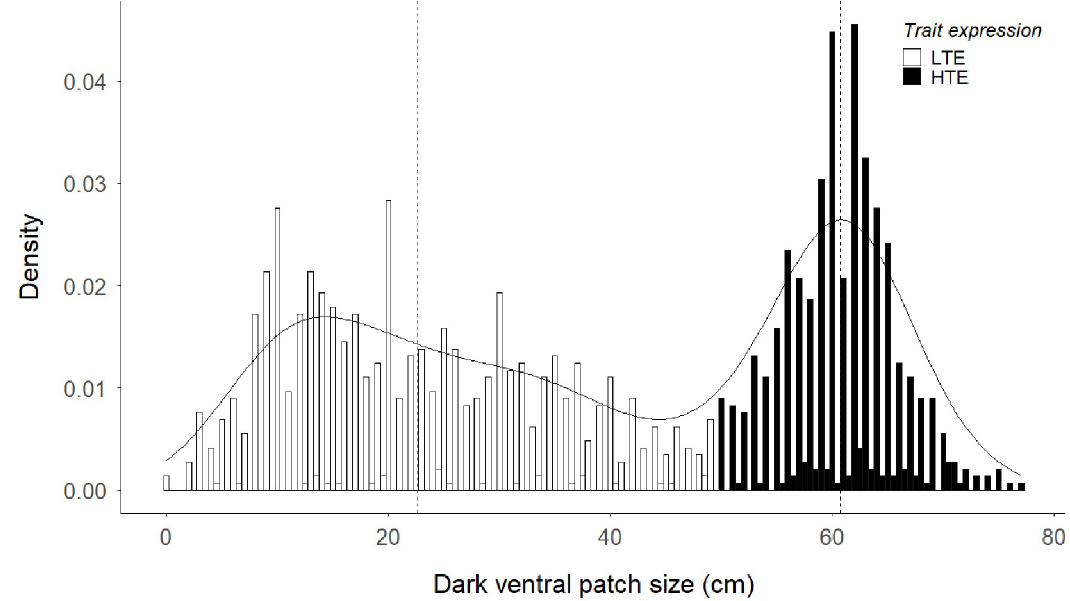
Fig 1. Density plot showing the bimodality distribution of the dark ventral patch size in male Iberian red deer. In black, high trait expression males (HTE), with patches larger than 50 cm. In white, low trait expression males (LTE), with patches between 0 cm to 50